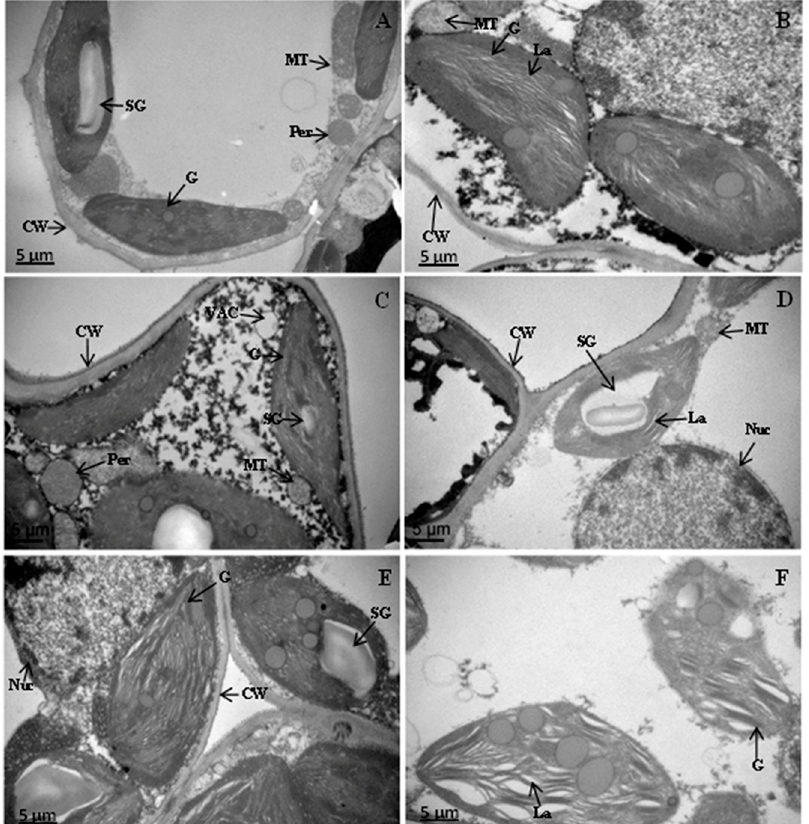
Figure 8. Electron micrographs of leaf mesophyll of cotton species (TM-1, Zhongmian-16 and Pima4-S) under drought stress and control conditions. The TEM micrograph of leaf mesophyll cells of TM-1, Zhongmian-16, and Pima4-S under control shows intact chloroplasts, well-developed grana (G), mitochondria (MC), starch grains (SG) with smooth cell wall (CW), and plasma membrane (PM). ( A , Control and B , drought) TEM micrographs of leaf mesophyll cells of TM-1 show oval shaped chloroplast fewer grana (G), swollen mitochondria (MC) with smooth cell wall (CW); ( C , control and D , drought) TEM micrographs of leaf mesophyll cell of Zhongmian-16 maintained elongated shape of chloroplast with less dense matrix of grana (G) raptured cell wall (CW), starch grain (SG), nucleolus present (Nuc), lamella (La) and mitochondria (MC); ( E , control and F , drought) TEM micrographs of leaf mesophyll cell of Pima4-S show oval shaped chloroplast fewer grana (G), lamella (La). Scale bars represent 5 µm.